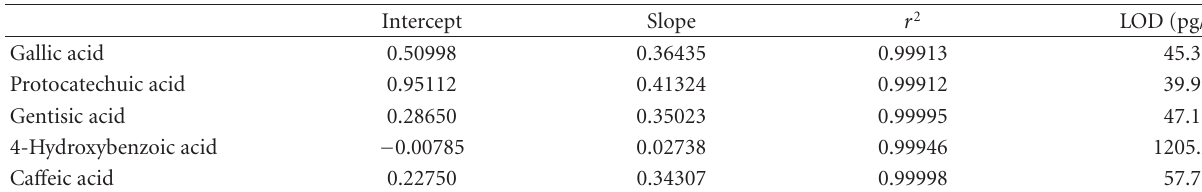
Table 1: Main calibration parameters of the HPLC-EC.